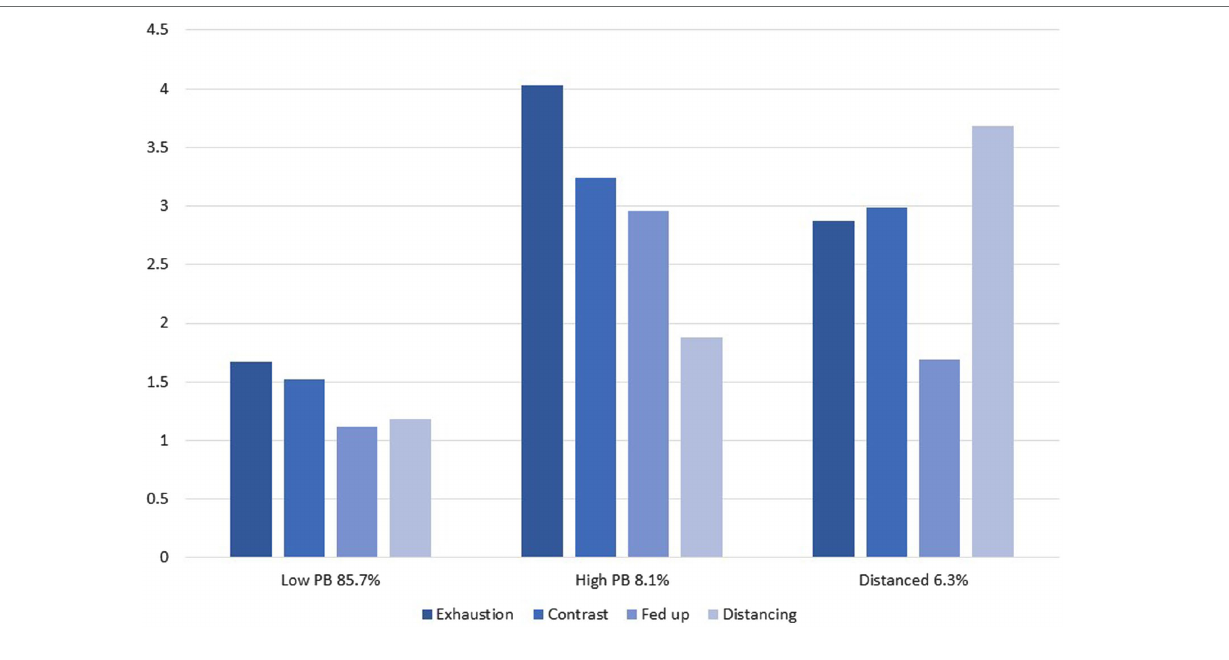
FIGURE 1 | Latent profiles of parental burnout.